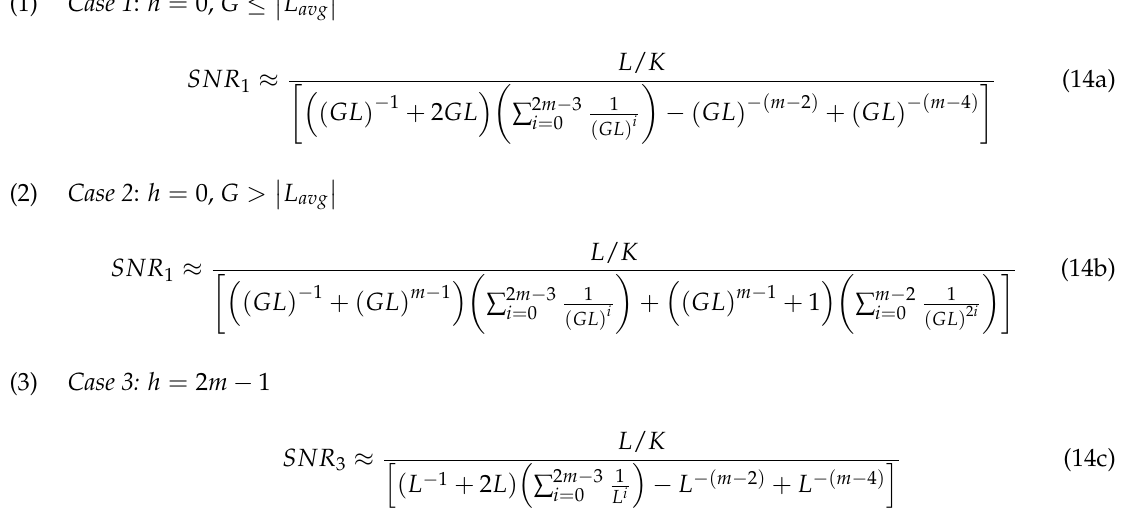
Figure 8. Worst-case SNR of the longest path in accordance with the SOA gain: ( a ) ℎ = 0 , 𝐺 ≤ (cid:3627)𝐿 (cid:3028)(cid:3049)(cid:3034) (cid:3627) ; and ( b ) ℎ = 0 , 𝐺 > (cid:3627)𝐿 (cid:3028)(cid:3049)(cid:3034) (cid:3627) .